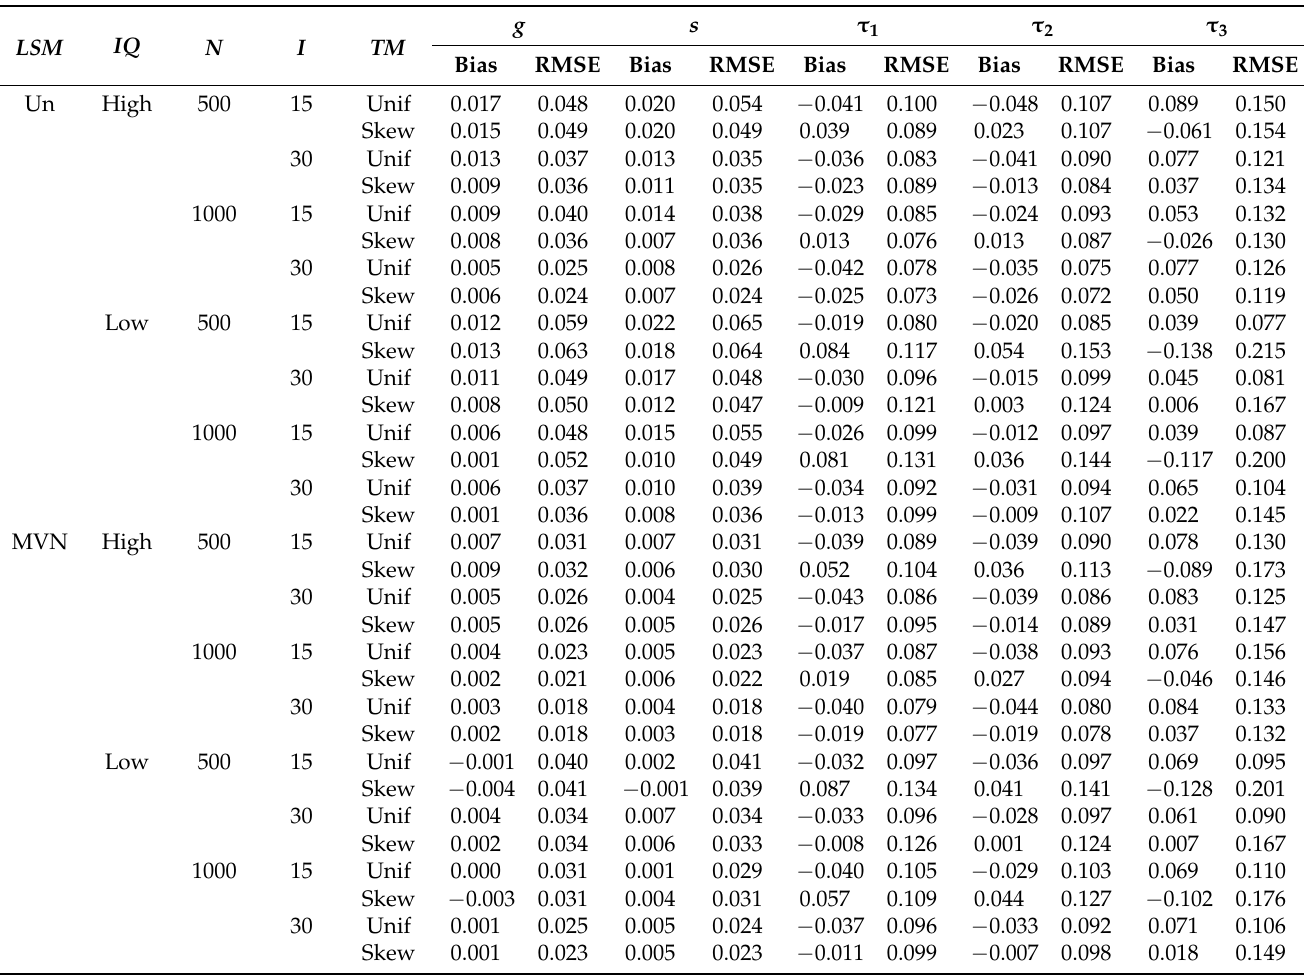
Table 2. Summary of the Recovery of Item Parameters in Simulation Study